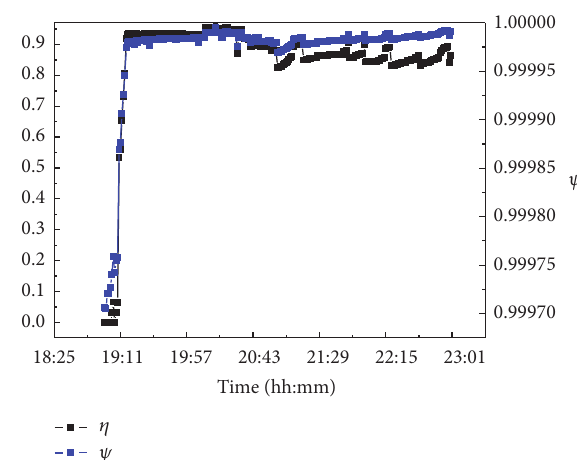
Figure 5: Energy efficiency and exergy efficiency of fan coil driven by